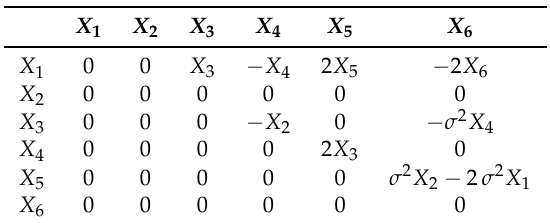
Table 3. Commutator table for the new basis { X i } of the Lie algebra of the Black–Scholes equation (and tumor equation with X i replaced by Y i